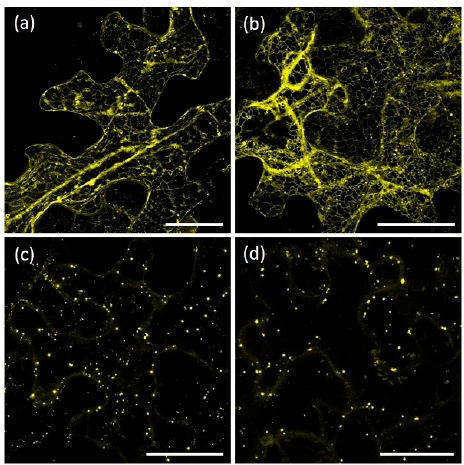
Figure 2. Localization of AtRMR1 and -2 in N. benthamiana leaves: ( a , b ) stacked confocal images of epidermal cells expressing either AtRMR1-YFP ( a ) or YFP-AtRMR1 ( b ); and ( c , d ) stacked confocal images of epidermal cells expressing either AtRMR2-YFP ( c ) or YFP-AtRMR2 ( d ). YFP signal ( a – d ). Scale bars = 30 µm.